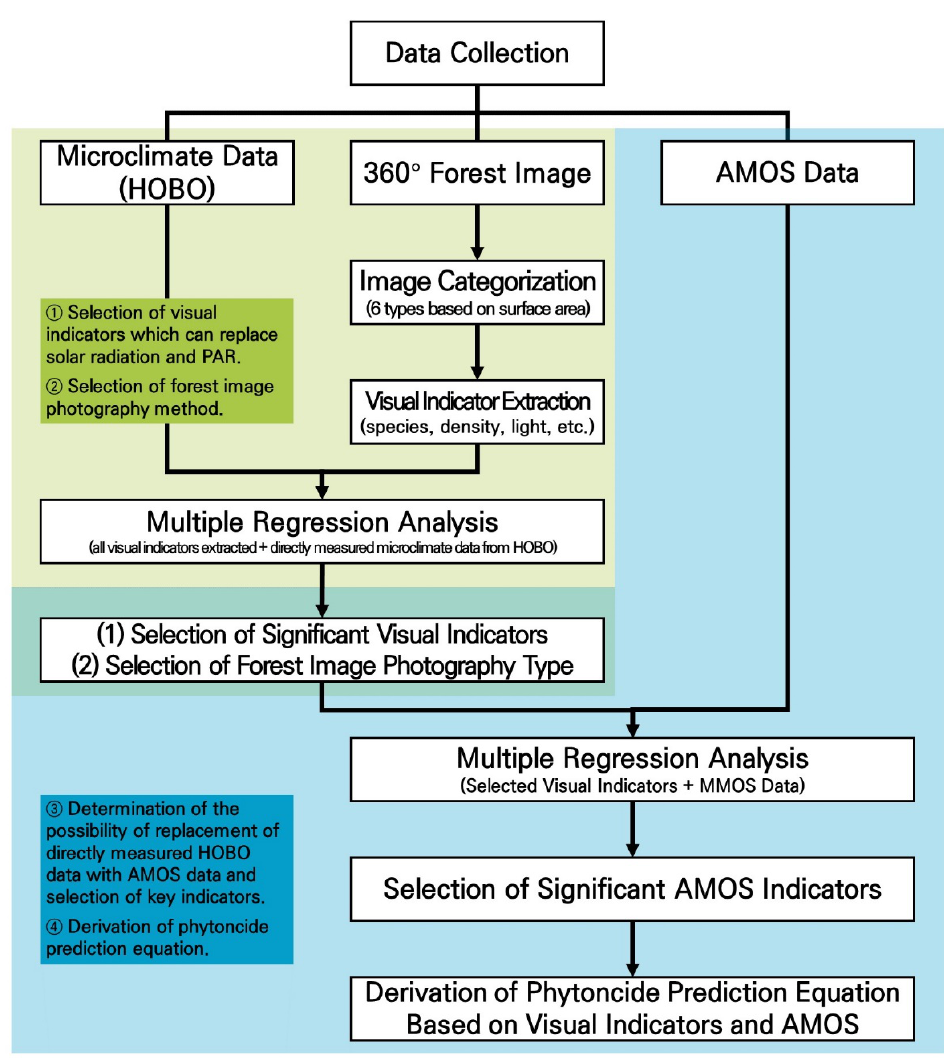
Figure 4. Flow-chart depicting the data analysis process.